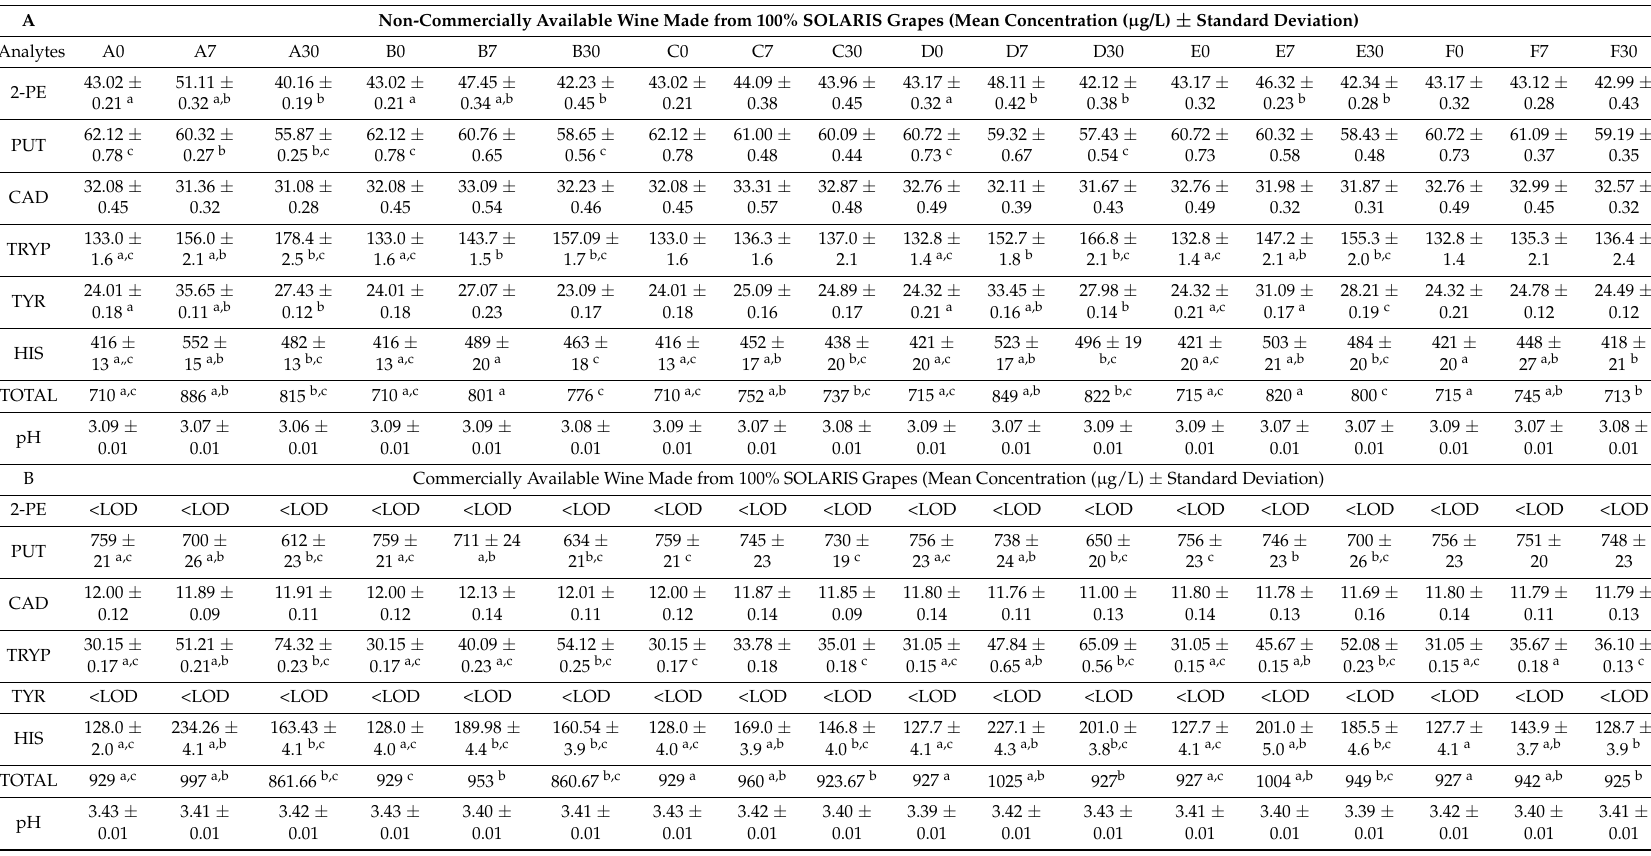
Table 1. Evolution of BA concentrations and pH in standard and high quality red wines and young white wine in different storage